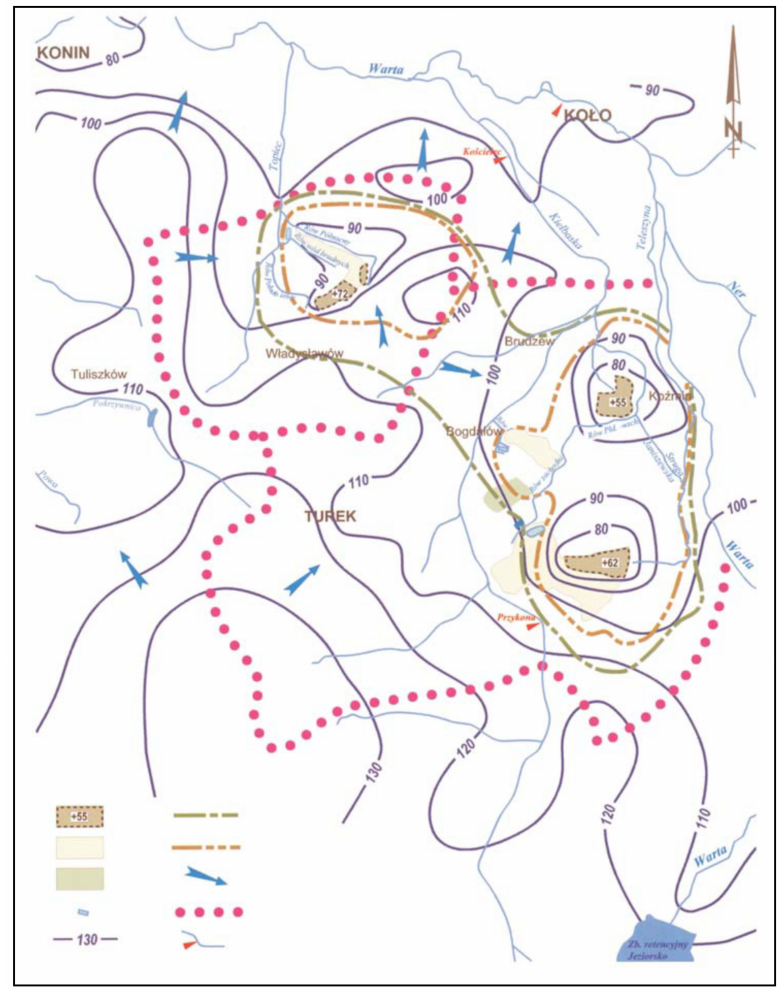
Figure 2. Location of coal deposits and cones of depression in the district of Turek as of 1996. Source: Map from [113]. Map legend as in Figure 1. Table 1. Characteristics of lignite open-cast mines in the Konin-Turek